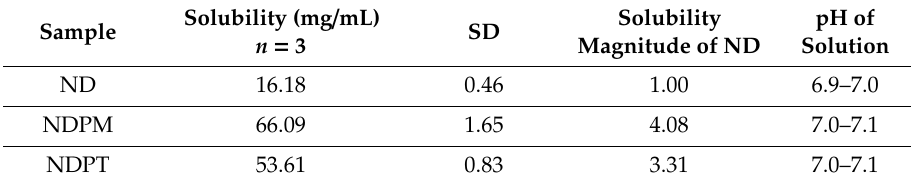
Table 3. Solubility curve (in CO 2 -free distilled water, pH 7.0) of ND, NDPM, and